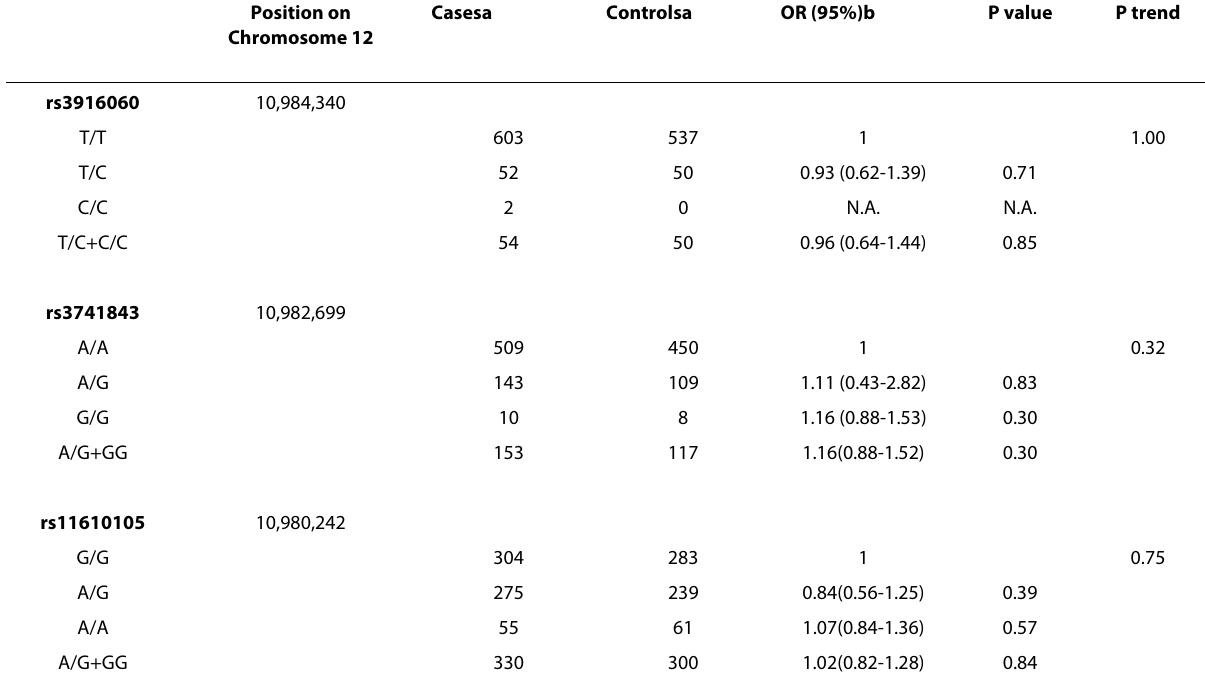
Table 2: Associations of TAS2R14 tagging polymorphisms with colorectal cancer